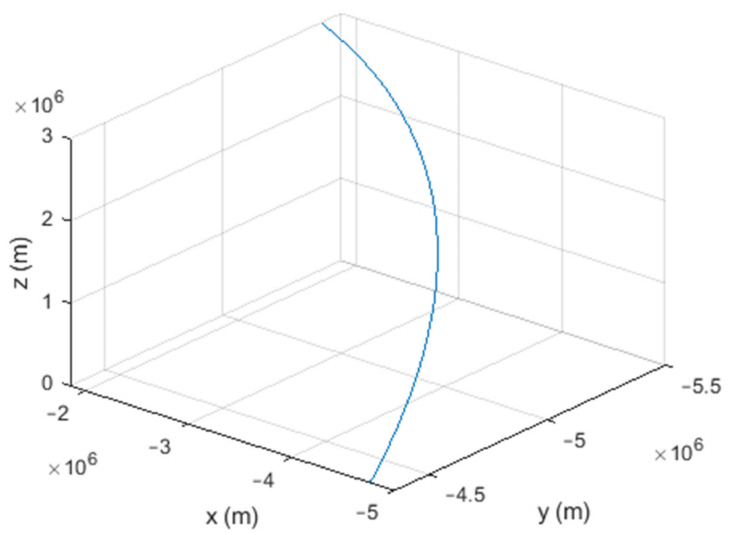
Figure 9. The sixth scenario: moving at a speed of about 7200 m/s in